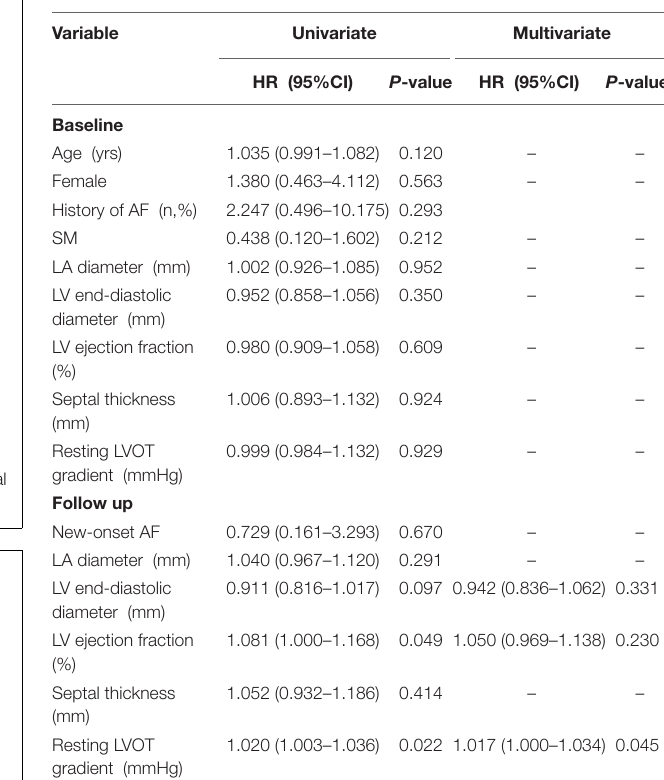
TABLE 3 | Predictors of all-cause